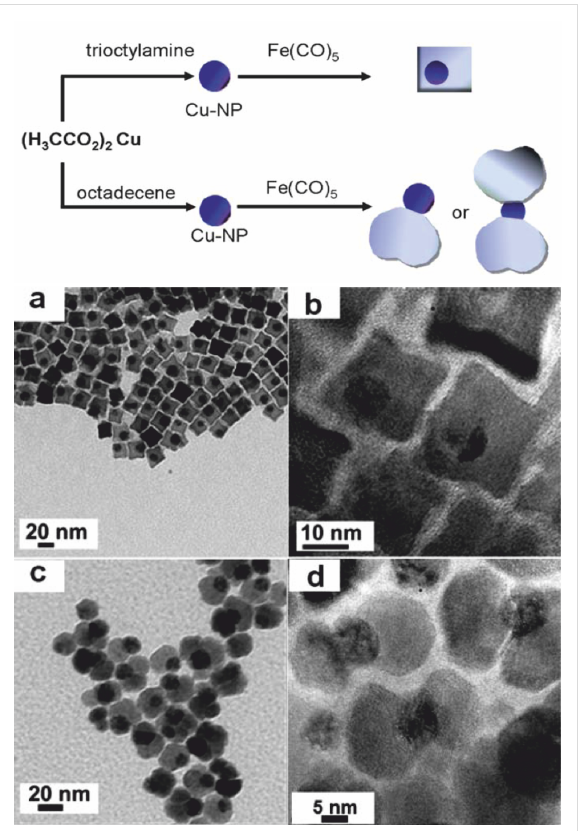
Figure 12: Schematic representation of the formation of Cu@Fe 3 O 4 heterodimers with different morphologies based on the use of solvents of various polarity (top) and corresponding (HR-)TEM images of (a, b) cube-shape, (c, d) cloverleaf-shape Cu@Fe 3 O 4 heterodimerparticles (bottom). Reproduced with permission from [57]. Copyright 2011 The Royal Society of